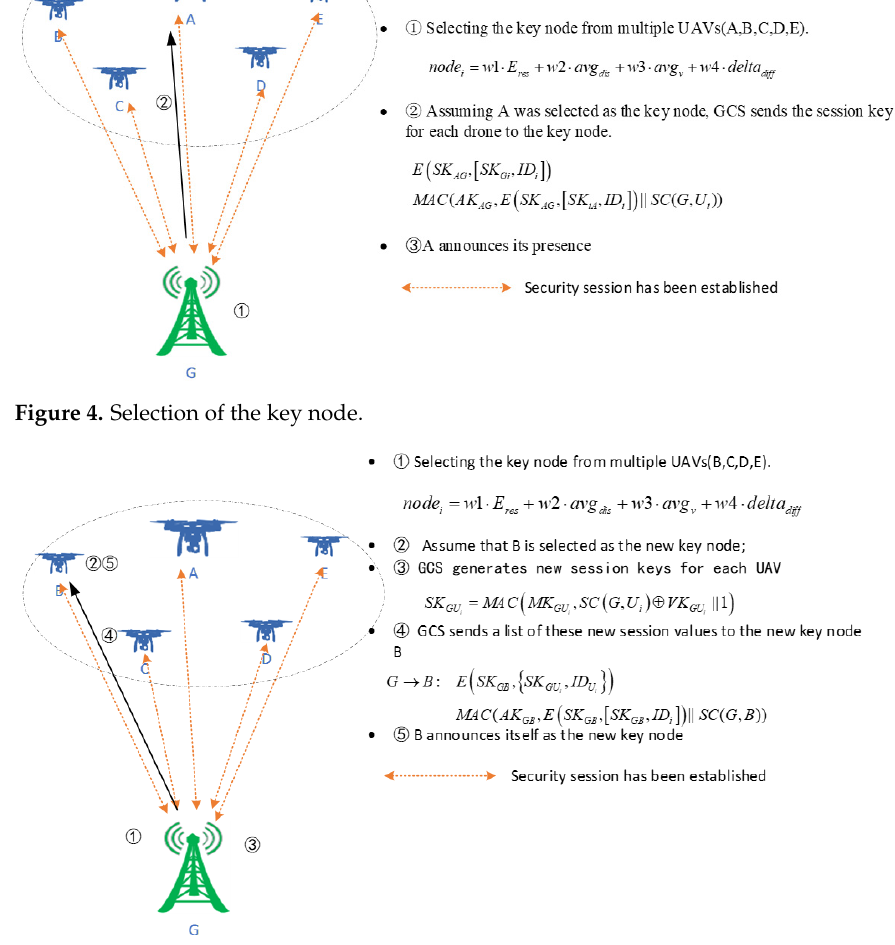
Figure 5. Refresh of the key node.